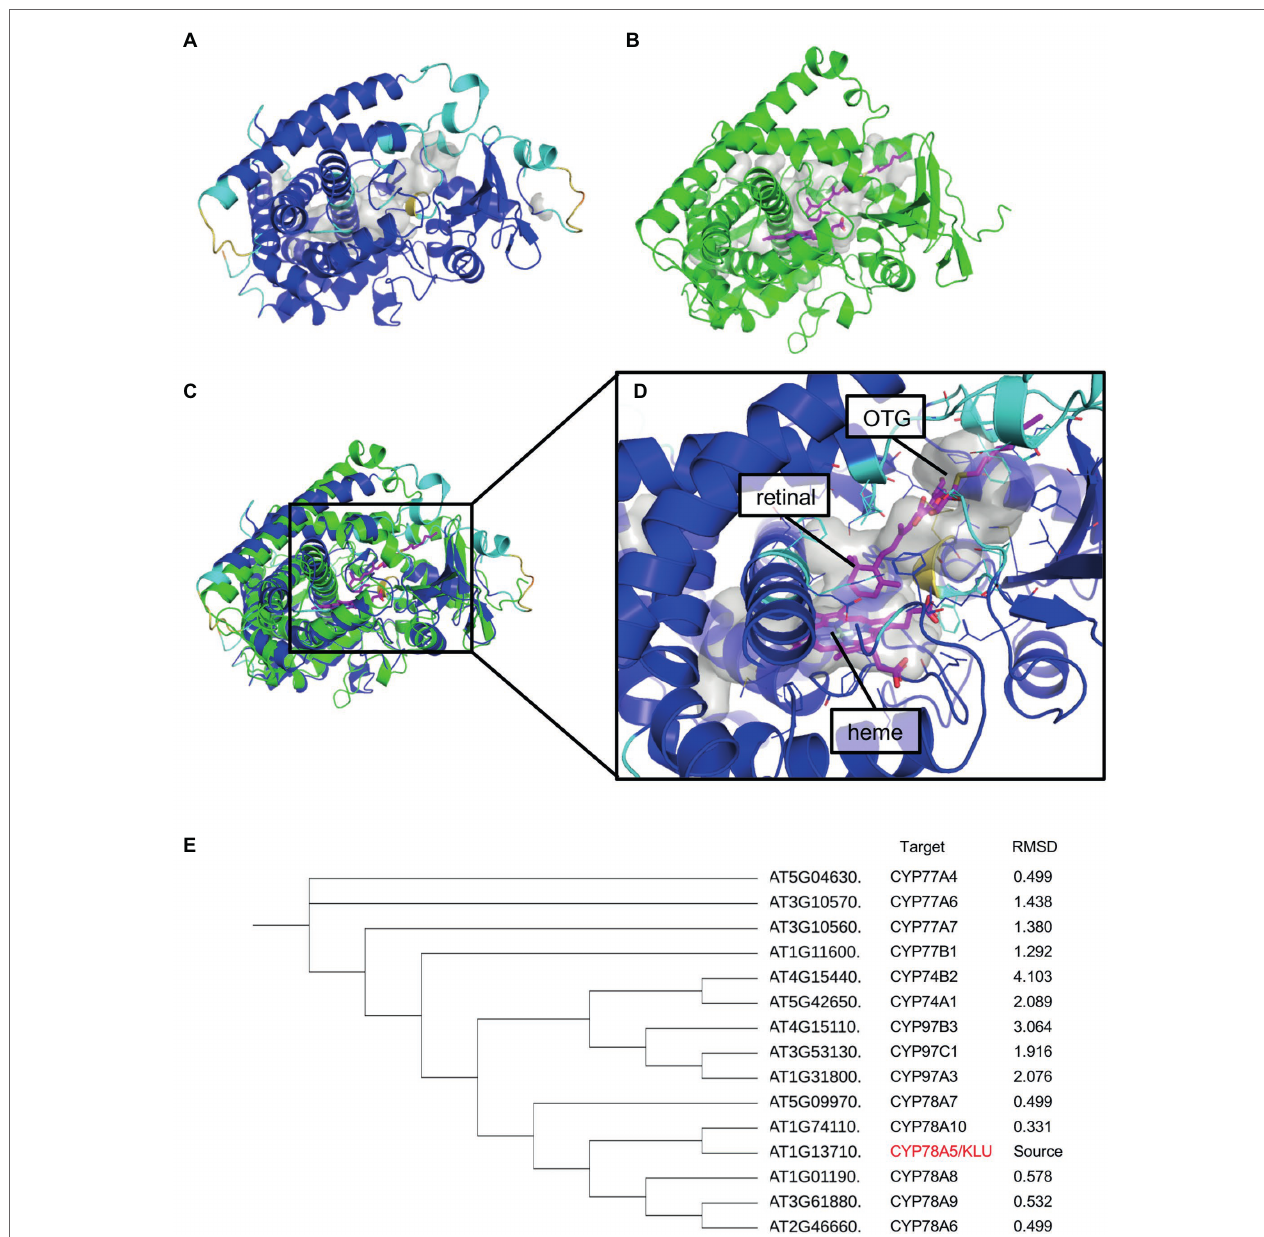
FIGURE 8 | Protein structure prediction of AtKLU. (A) The predicted structure of CYP78A5 colored according to the pLDDT values [blue (high) to yellow (low)]. The internal cavity of CYP78A5 is shown as a gray surface. (B) The crystal structure of CYP97C1 (green) with heme and octylthioglucoside (OTG; magenta). The location of retinal (magenta) was modeled by superposing the CYP97A3-retinal complex (PDB ID: 6L8J) onto CYP97C1 (PDB ID: 6L8H). The putative lutein-binding cavity in CYP97C1 is shown as a gray surface. (C) Superposition of CYP78A5 and CYP97C1. (D) The predicted active site of CYP78A5 [enlarged from (C) ]. The residues involved in constructing the internal cavity are shown as line models. The location of heme, OTG, and retinal (magenta) were modeled by superposing CYP97C1 onto the CYP78A5 model. (E) Phylogenetic tree created from amino acid sequences of CYP-74, -77, -78, and -97 with root mean square deviation (RMSD)